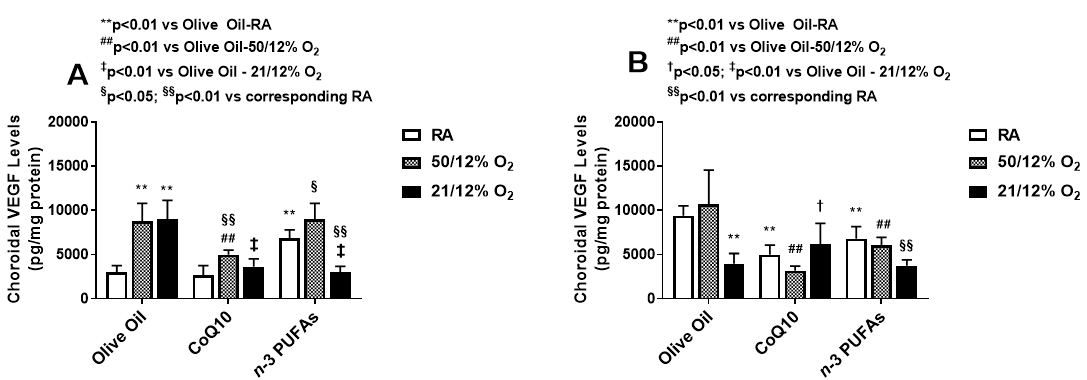
Figure 3. Effect of CoQ10 or n -3 PUFA supplementation in IH on choroidal VEGF levels. Data are mean ± SD. n = six samples/group (** p < 0.01 vs. olive oil in RA; ## p < 0.01 vs. olive oil in 50/12% O 2 ; † p < 0.05, ‡ p < 0.01 vs. olive oil in 21/12% O 2 ; and § p < 0.05; §§ p < 0.01 vs. corresponding treatment in RA). RA (room air); VEGF (vascular endothelial growth factor).